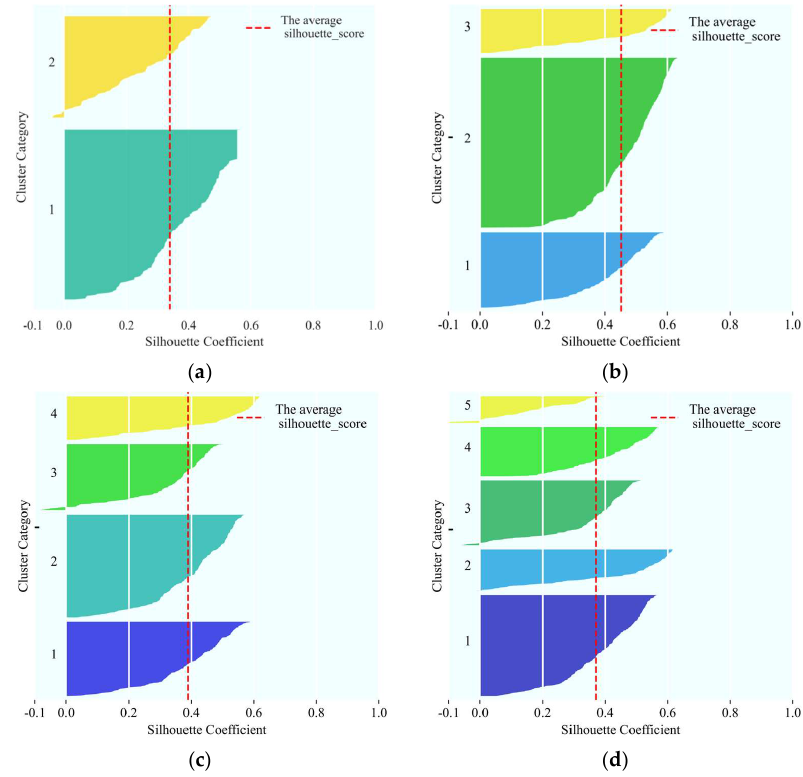
Figure 9. Comparison of silhouette coefficients under different cluster numbers. ( a ) The number of clusters is 2, ( b ) the number of clusters is 3, ( c ) the number of clusters is 4, ( d ) the number of clusters is 5. The silhouette coefficients (SC) and Calinski–Harabasz (CH) scores of the different clustering results are shown in Figure 10, it can be seen that the average SC are 0.340, 0.451, 0.389, and 0.371 and the CH score is 143.5, 573.3, 594.3, and 537.7 when the cluster number is two, three, four, and five clusters, respectively. Although the CH score is higher when the cluster number is four, the SC score is relatively low at this time, while the SC and CH scores are high when the cluster number is three, so it is more reasonable to set the number of clusters to three. Figure 10. Silhouette coefficients and Calinski–Harabasz Score.